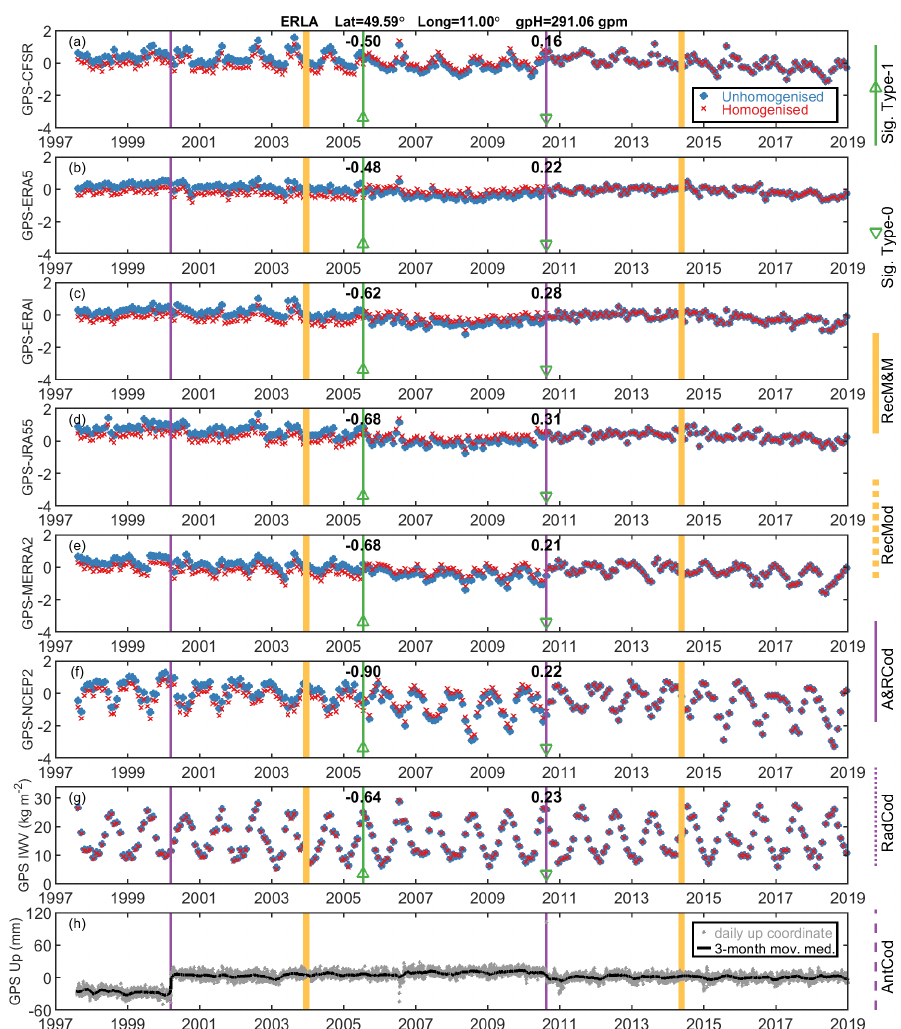
Figure A2. The same as Fig. A1 but for station ERLA. A Type-0 changepoint is significant on 18 August 2010 (green triangle) due to changes in the antenna and radome at the station. A Type-1 changepoint in July of 2005 (green vertical line and upward-pointing triangle) is significant but without support from metadata, and hence its date was fixed to 15 July 2005.